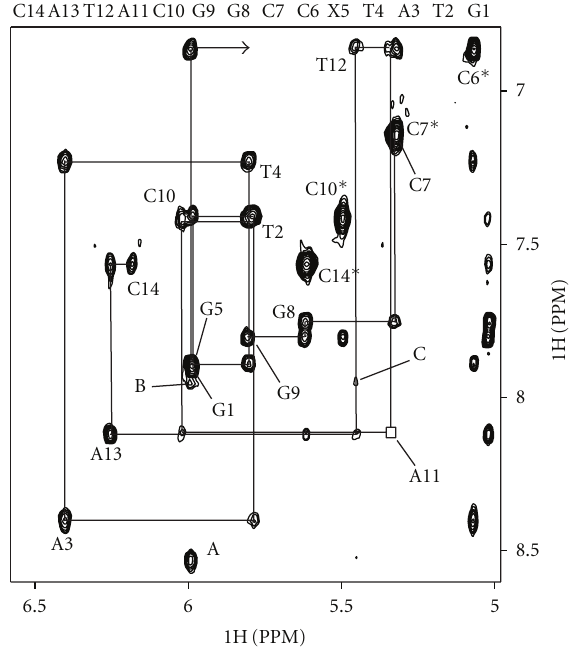
Figure 3: Expanded contour plot showing the finger print region of a 300 ms mixing time NOESY spectrum (600MHz) of the 14-mer dG( N 2 )-3ABA duplex dissolved in 100% D 2 O phosphate bu ff er, pH 6.9. The labels identify cross-peaks between the purine(H8), or pyrimidine(H6), and the H1 (cid:2) sugar proton of the same residue. Asterisks indicate cytosine(H5-H6) interactions. Other labels are assigned as follows: A, 3ABA(H2)-G5(H1 (cid:2) ); B, 3ABA(H3)-G5(H1 (cid:2) ); C, 3ABA(H3)-T12(H1 (cid:2) ). The arrow points to the position of C6(H1 (cid:2) ) that resonates outside of the plotted region, at 4.43